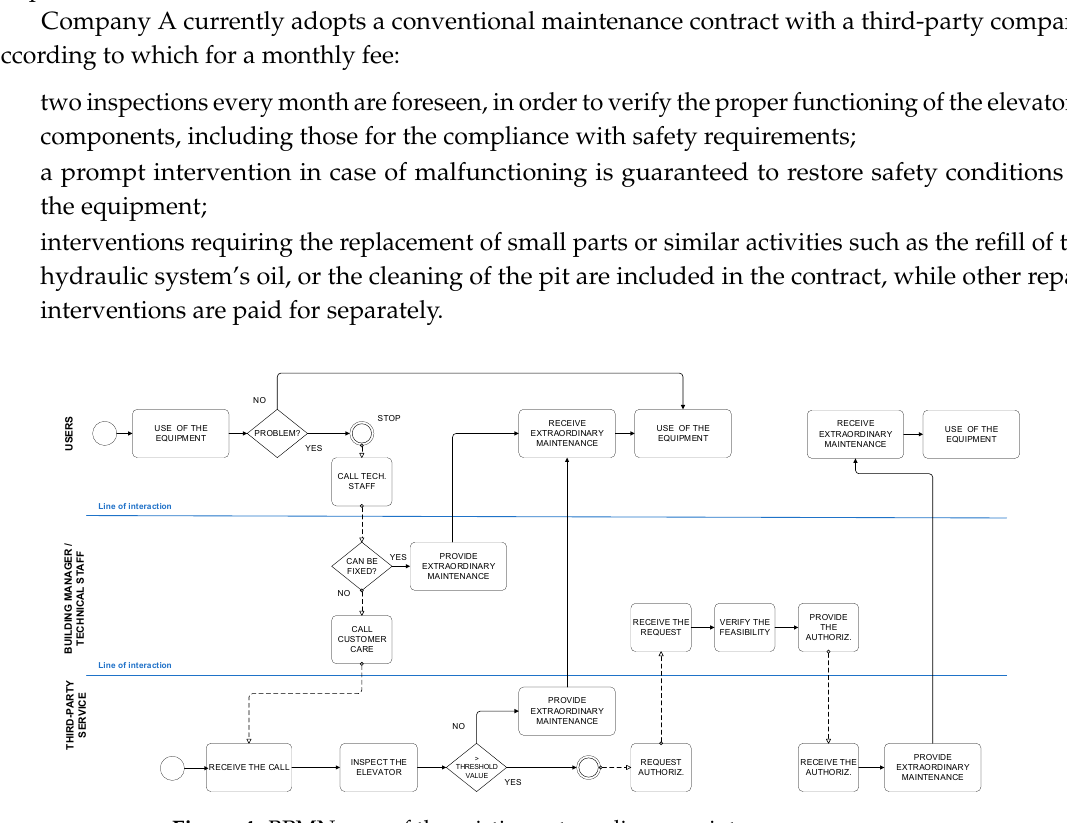
Figure 4. BPMN map of the existing extraordinary maintenance processes.